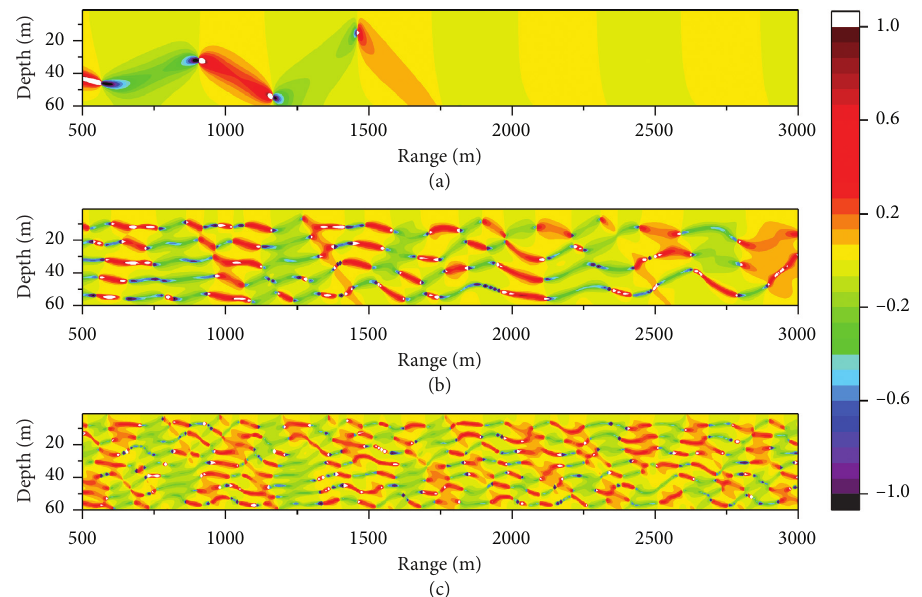
Figure 17: I ∗ z for different compute frequencies when ρ 1 f � 190Hz; (c) f � 360Hz). 0 0